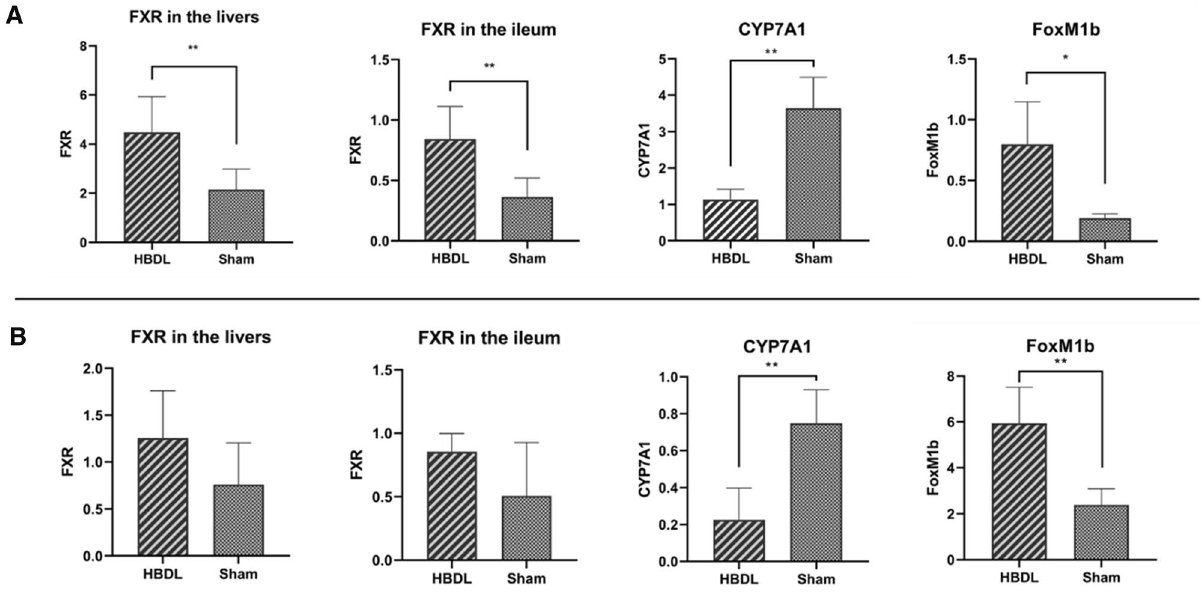
Figure 6. Expression of FXR in the livers, FXR in the ileum, CYP7A1 in the livers and FoxM1b in the livers of HBDL mice at the mRNA at different time points. The first day after the operation ( A ) and the first week after the operation ( B ) is indicated. * p < 0.05 versus the sham